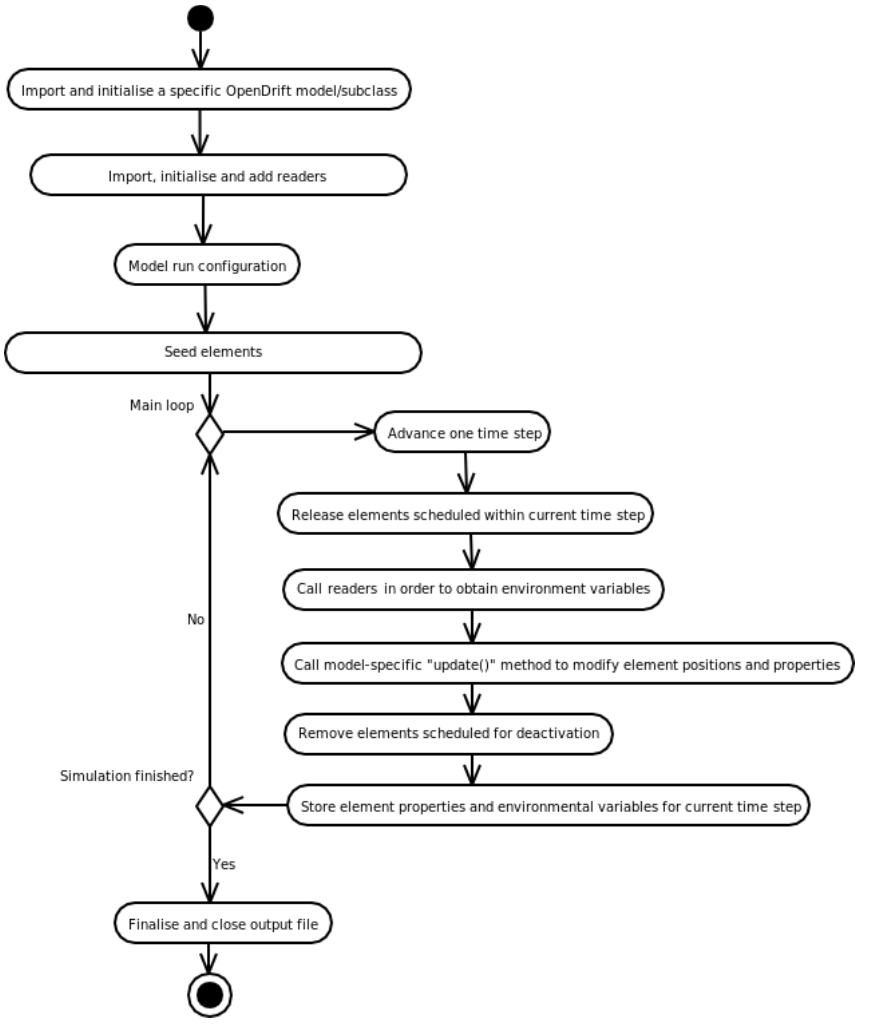
Figure 1. Flowchart of an OpenDrift